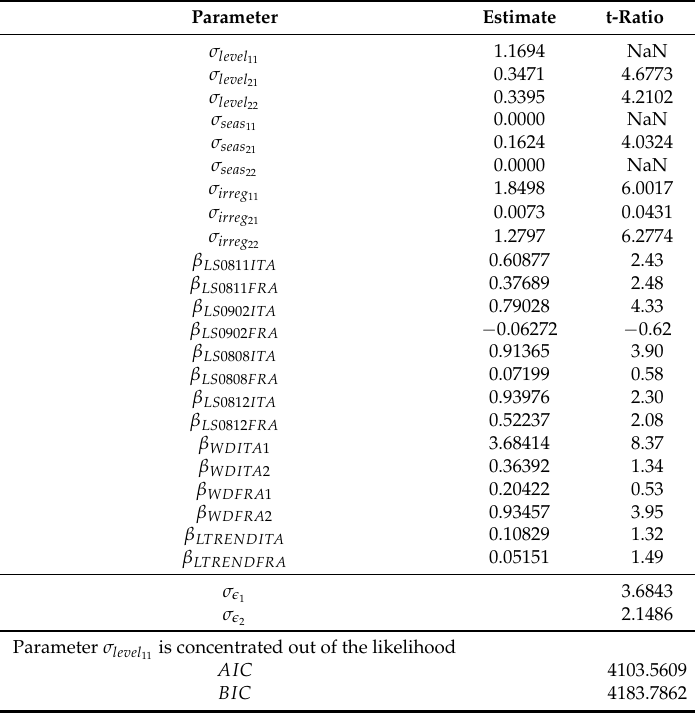
Table A12. Endogenous variables: IPI t capital goods LCVFR t in France.